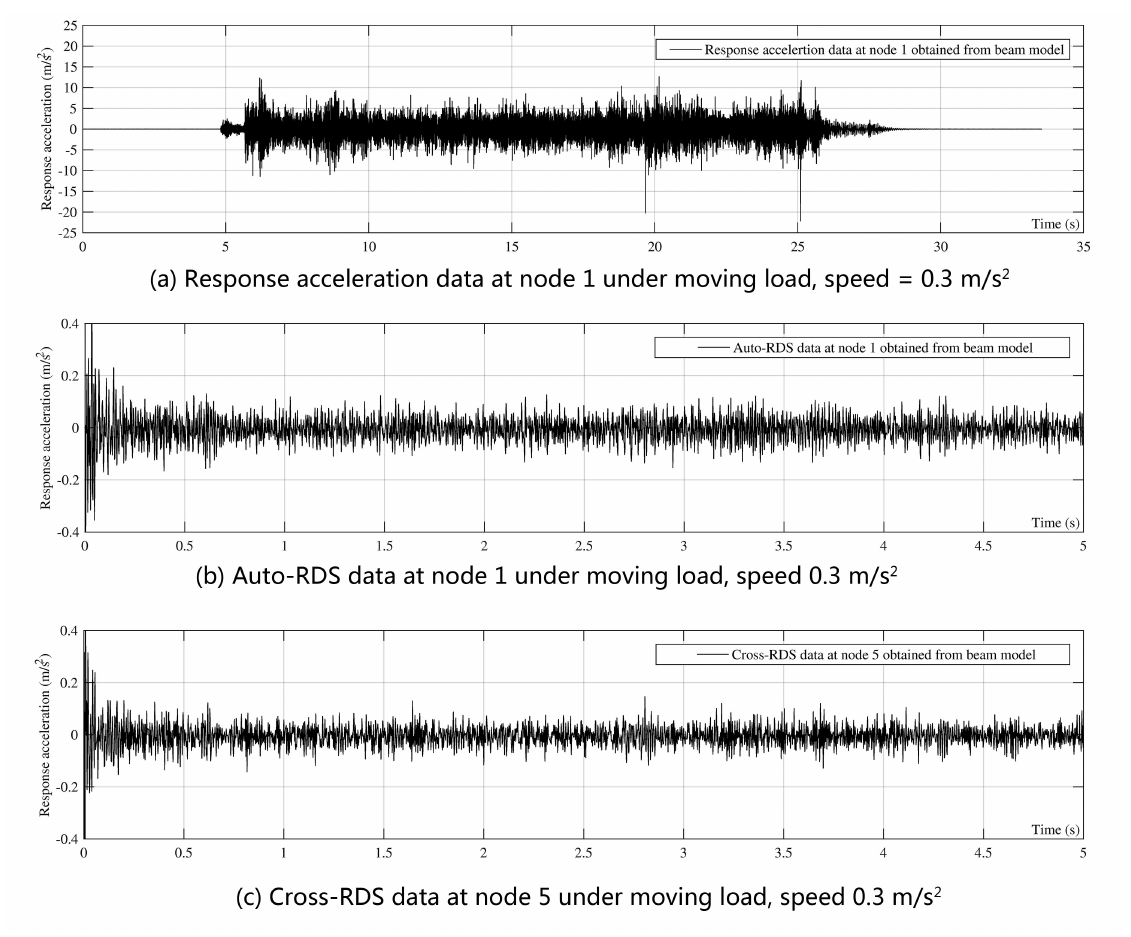
Figure 10. ( a ) Response acceleration data recorded at node 1; ( b ) auto-RDS of node 1; and ( c ) cross-RDS of node